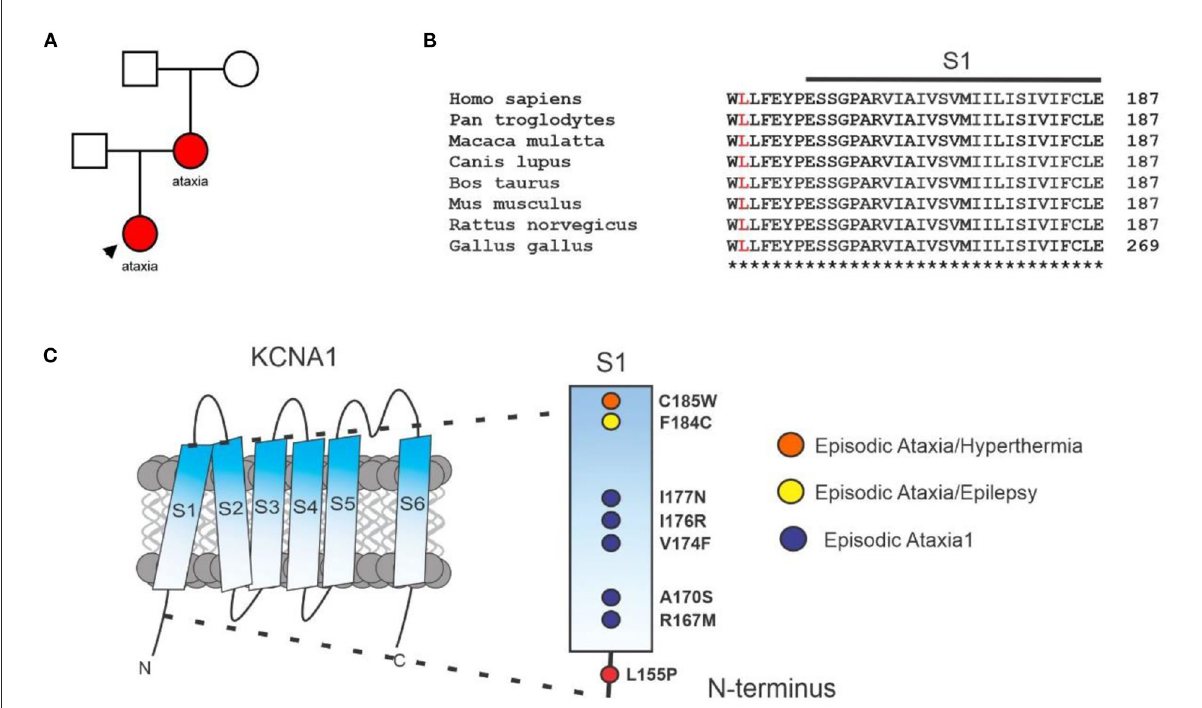
FIGURE1 Clinical genetics. (A) Pedigree diagram for KCNA1-L155P (red) in the family under study. (B) Sequence alignment for S1 and S1-proximal N-terminal segment of KCNA1 with L155 highlighted (red). (C) Location of L155P and some previously reported EA1 sequence variants in KCNA1 (see Discussion).